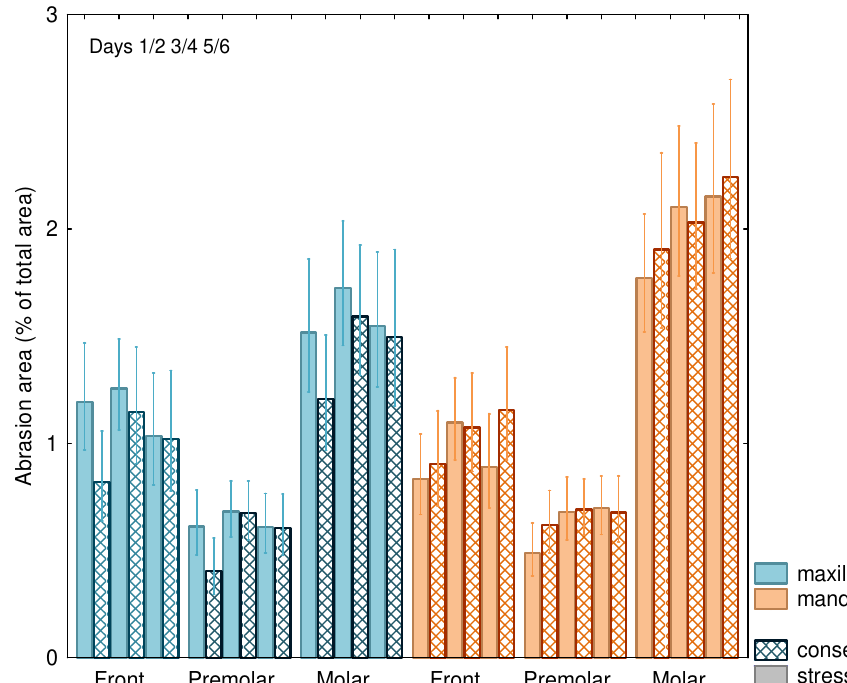
tively larger than those of the maxilla (Figure 3), while areas for the frontal and premolar teeth showed less difference between the mandible and the maxilla, resulting in a highly significant ( p = 0.003) interaction effect (Table 2).